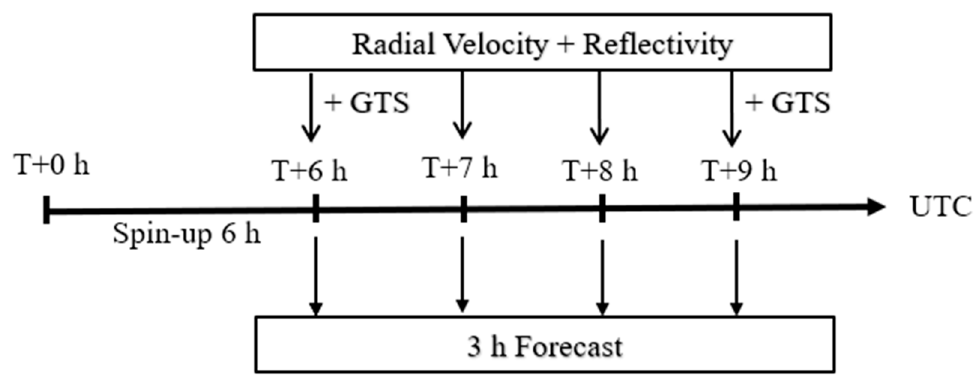
Figure 5. Schematic diagram showing the assimilation and forecast cycles.